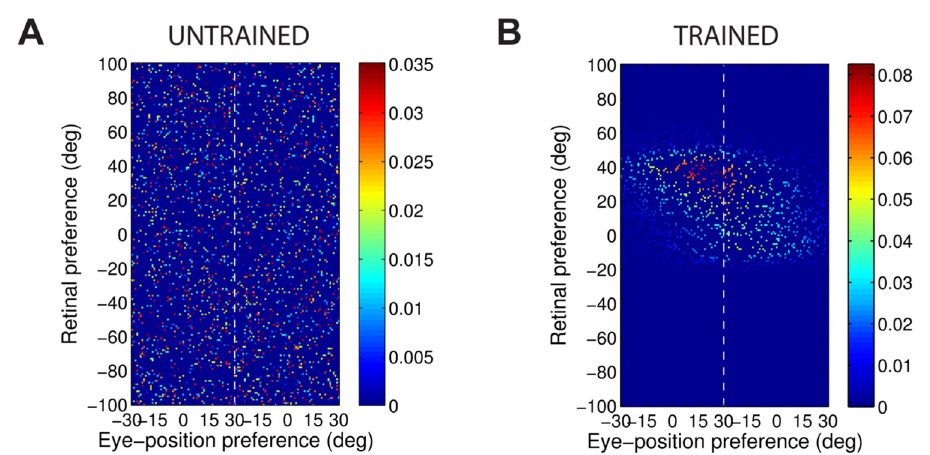
Fig 19. Simulation results showing the strengths of the afferent synapses of a model incorporating a population of sigmoidal modulated input neurons trained with the modified learning rule 19: Current postsynaptic trace with anti-Hebbian learning. The figure shows the strengths of the afferent synapses from the input population to output neuron #328 for the untrained (A) and trained (B) model. The output neuron corresponds to the one plotted in Fig 18. Conventions as for Fig 13. The synaptic weight structure for this output neuron after training shown in plot (B) has the correct kind of profile for a head-centred neuron (Fig 8).